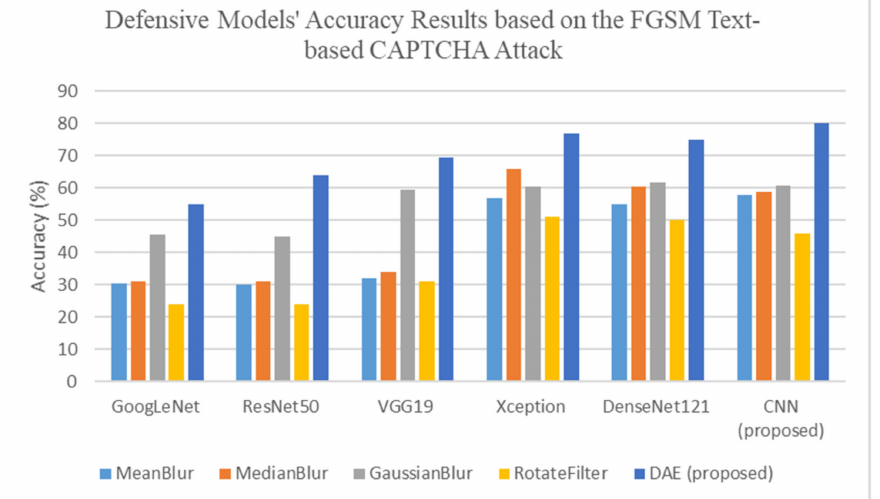
Figure 16. Comparison results of the testing accuracies obtained by the defensive models based on the FGSM text-based CAPTCHA attack.